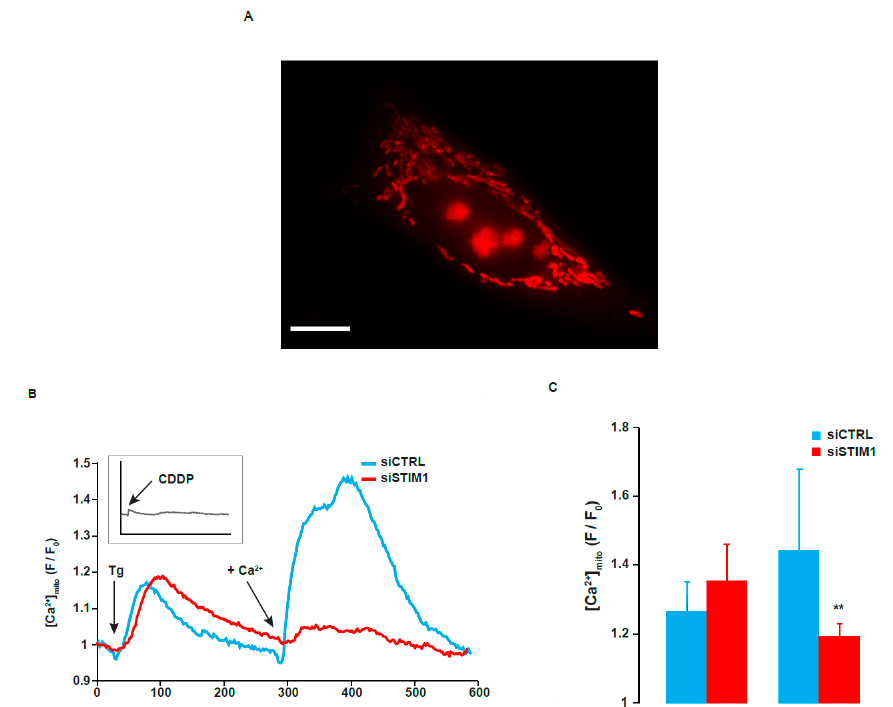
Figure 8. Influence of STIM1 depletion on mitochondrial Ca 2+ concentration. ( A ) After transfection with siCTRL or siSTIM1, A549 cells were stained with Rhod-2/AM to allow cytosolic mitochondrial Ca 2+ measurement. Tg was added in the absence of external Ca 2+ , in a solution of Krebs EGTA. The first Ca 2+ peak reflects the release of Ca 2+ from the ER. After ~4 min, Ca 2+ was added in the external medium, allowing SOCE. A Representative picture of A549 cell stained with Rhod-2. Scale bar = 10 µm. ( B ) Traces are representative of at least eight independent experiments (between 5 and 20 cells analyzed per experiment). Fluorescence at the indicated time is related to the fluorescence at the beginning of the experiment (F/F 0 ). The acute effect of 25 µM CDDP on mitochondrial Ca 2+ is shown in the insert (same scale as the main graph). ( C ) Quantification of experiments presented in B. Results are expressed as means ± S.D. ( n = 8 for siCTRL transfected cells and n = 9 for siSTIM1 transfected cells).